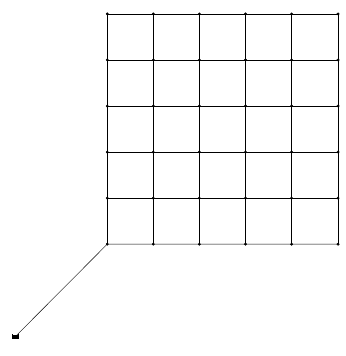
Figure 2. B-City water distribution network.